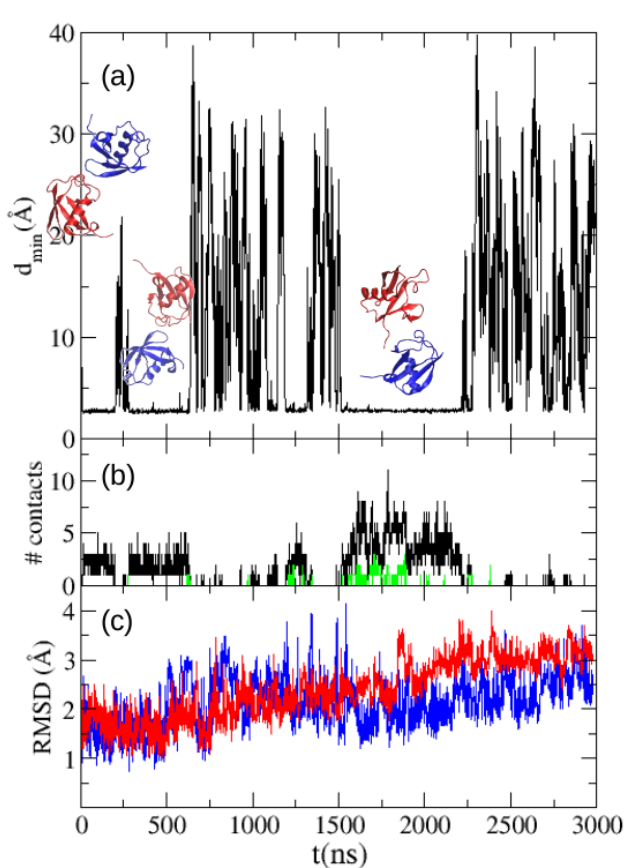
Figure 4. ( a ) Minimum distance between two ubiquitin molecules in a molecular dynamics simulation of a solution of ubiquitin at a concentration of 5 mM with the TIP4P/2005 water model. The most stable bound structures found during the simulations are shown. ( b ) Number of intermolecular contacts found along the simulations. Green line: number of contacts formed between residues of the experimental interface (see main text) ( c ) RMSD to the crystallographic structure of ubiquitin of the two ubiquitin molecules along the simulation.